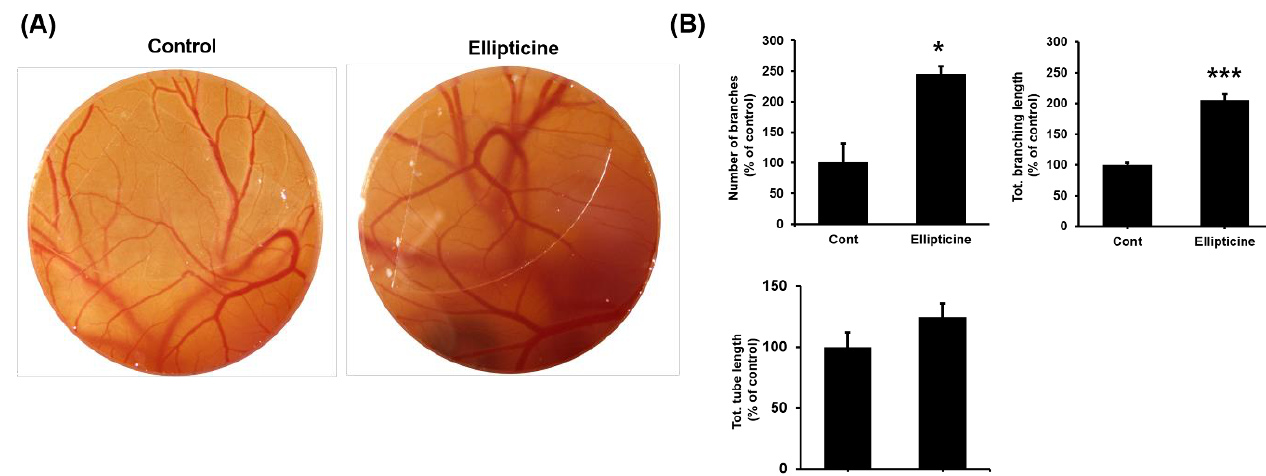
Figure 6. Chorioallantoic membrane (CAM) assay for pro-angiogenic effect. CAMs were treated with either 156.25 nM ellipticine or DMSO as a control for 96 h ( A ). The number of branches, total branch length, and total tube length were measured and shown ( B ). * p < 0.05, *** p < 0.001.